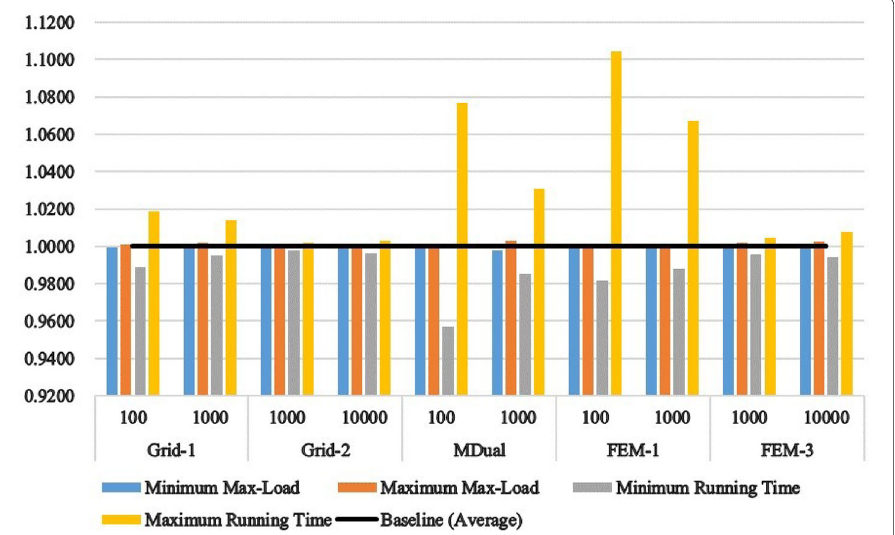
Fig. 4 The ratios of best and worst max-load and running time to the relative average results. The baseline is the relative average